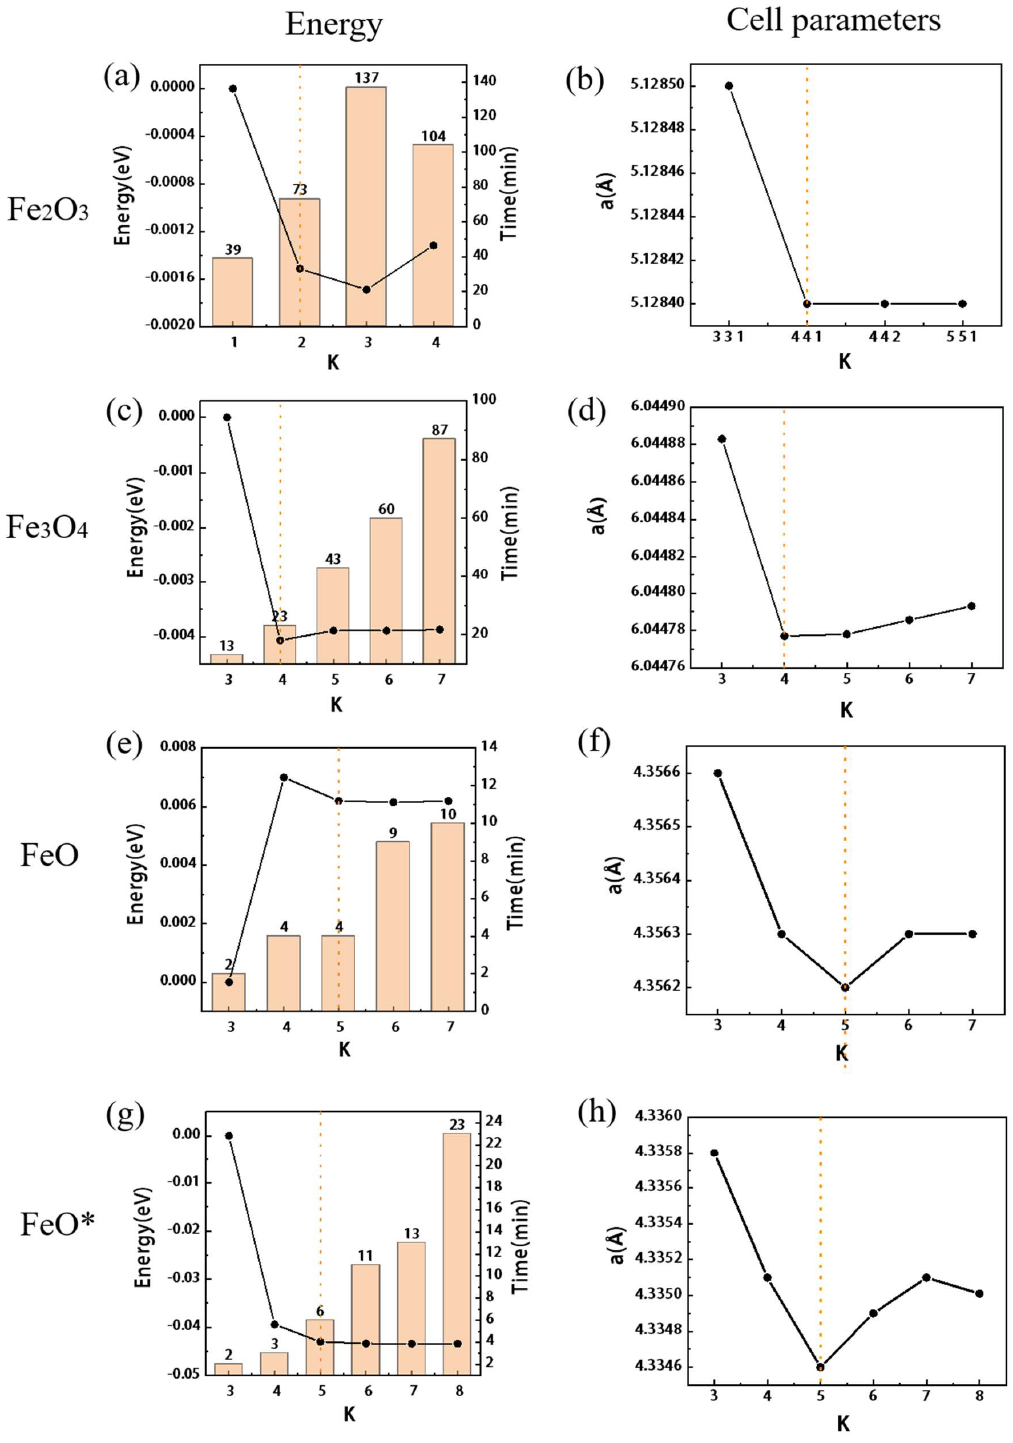
Figure 4. The test results of the k-point for three iron oxides, the horizontal direction is the parameter of the same oxide (( a , b ) for Fe 2 O 3 , ( c , d ) for Fe 3 O 4 , ( e , f ) for FeO, ( g , h ) for FeO*), and the vertical direction is the comparison of the same calculation result. The histogram is the calculation time, the orange dotted line is the position of the final